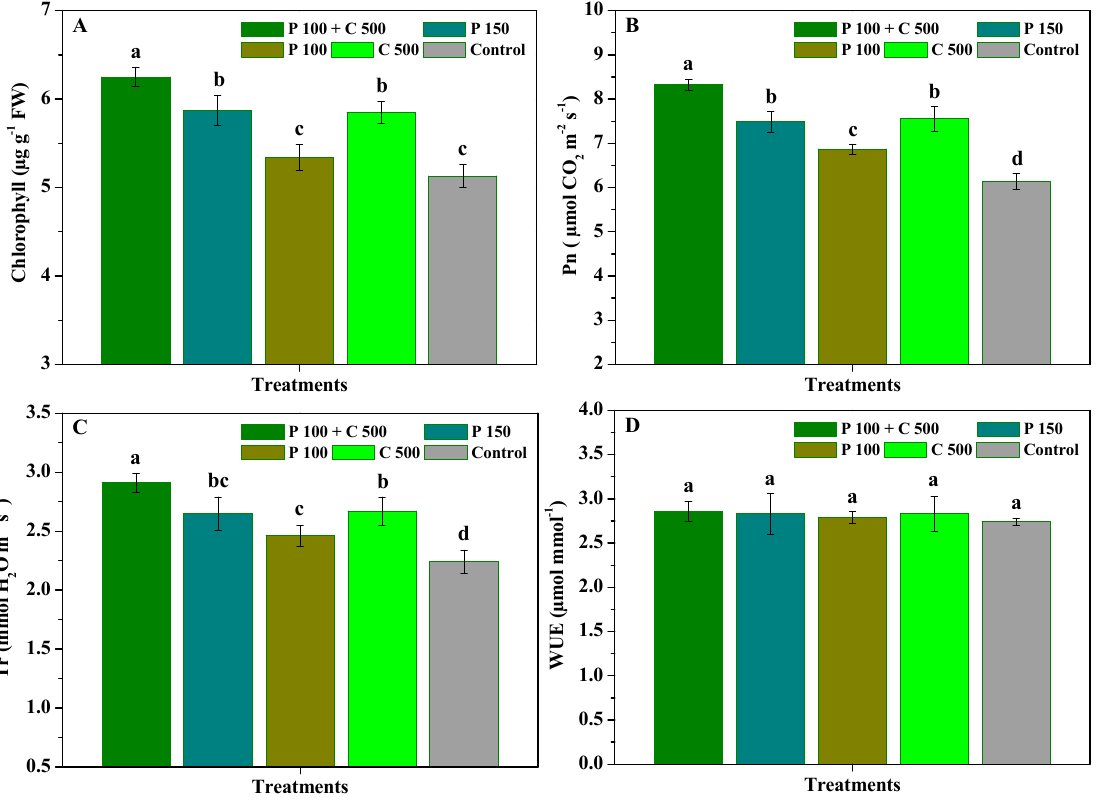
Figure 4. The influence of pyraclostrobin and chitosan on the chlorophyll ( A ), Pn ( B ), Tr ( C ) and WUE ( D ) of R. roxburghii leaves. Error bars indicate the SD of the three replicates. Small letters represent significant differences on a 5% ( p < 0.05) level.